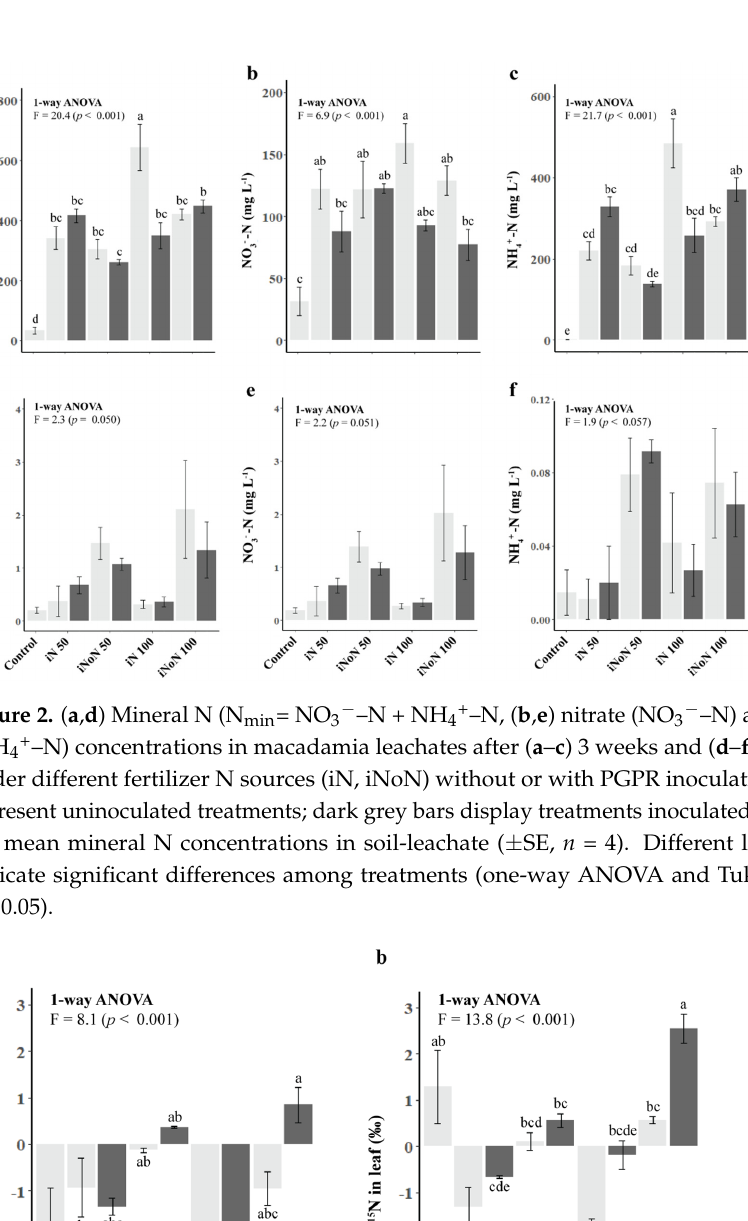
Figure 4. Copy numbers of the ( a ) 16S rRNA gene and ( b ) PGPR strain-specific gene PB_SOS3_004375 from rhizosphere potting mix of macadamia seedlings after 12 weeks (light grey bars) and 28 weeks (dark grey bars) growing under different fertilizer-N sources (iN, iNoN) without or with PGPR inoculation. Shown are the total number of gene copies per mg of soil (±SE, n = 3). Asterisks and parentheses in panel ( b ) indicate significant differences between time points within treat- ments (one-way ANOVA, p < 0.05), while different lowercase letters above means indicate significant differences among